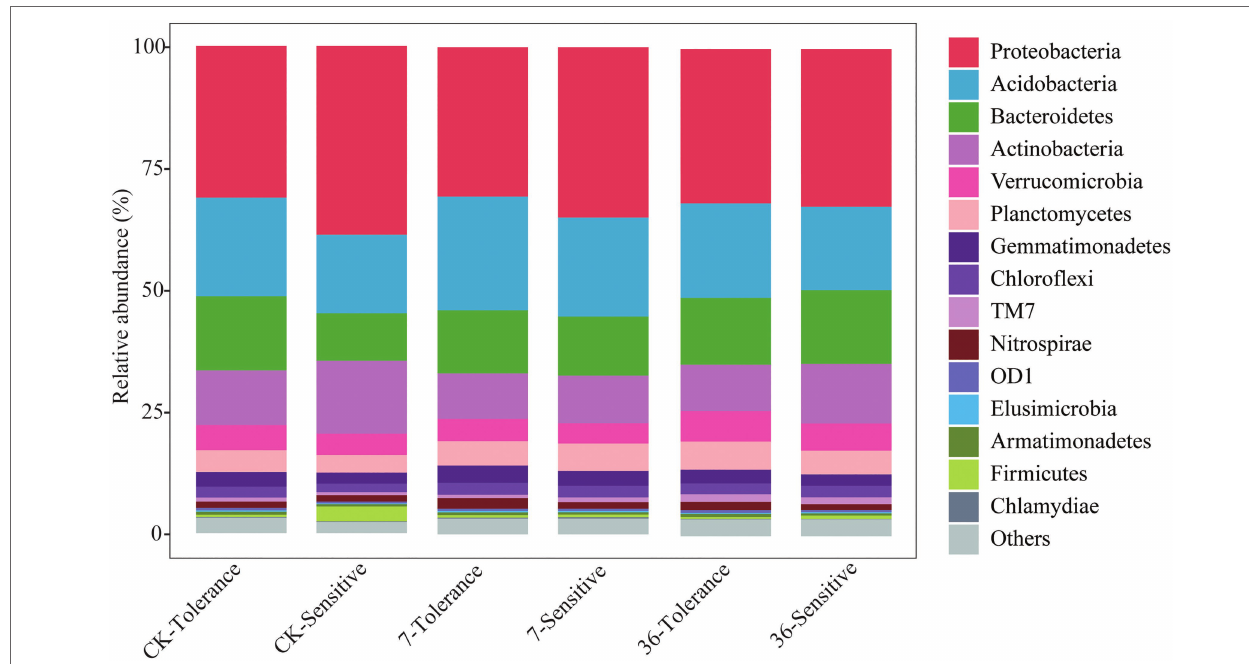
FIGURE 3 | Relative abundance of the phylum of different